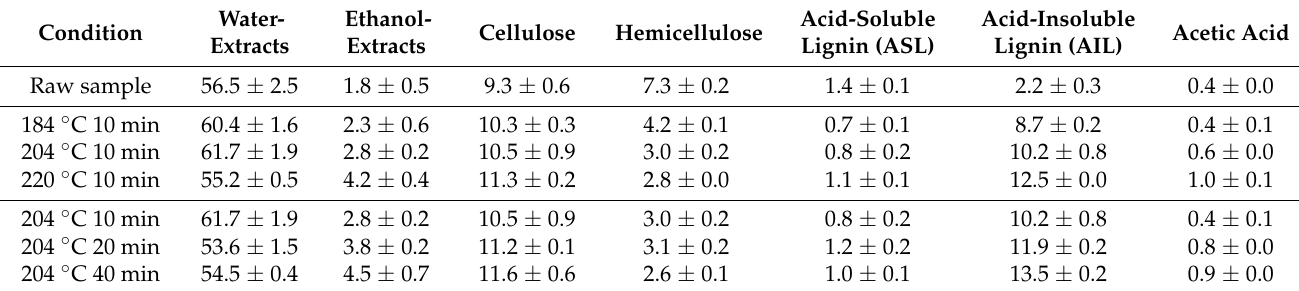
Table 1. Chemical composition (g/100 g dry weight) of raw b roccoli and SE broccoli.